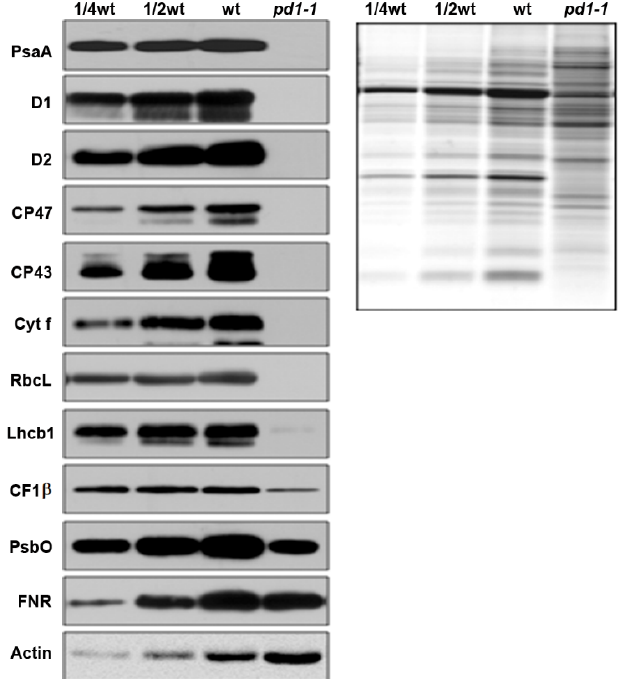
Figure 3. Immunoblot analysis of photosynthetic proteins in wild type and pd1-1 seedlings. Im- munoblot analysis of photosynthetic proteins based on the equal total leaf proteins was performed using two-week-old wild type and pd1-1 seedlings that were grown on MS medium with 3% sucrose. Total leaf proteins were extracted and separated by SDS-urea-PAGE. The immune detection was probed with specific antibodies.